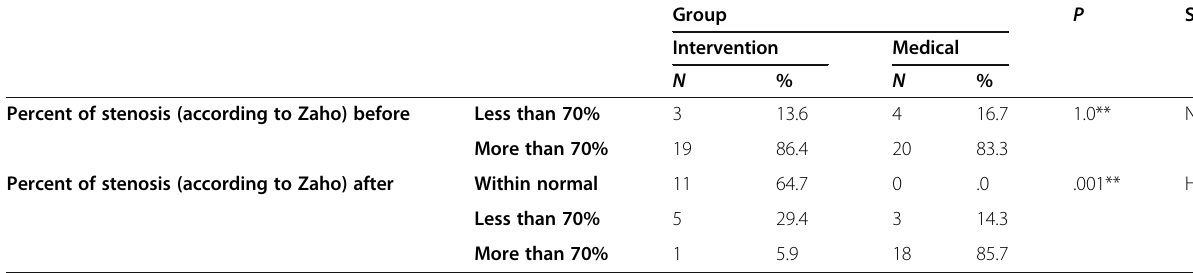
Table 8 Percent of stenosis among both groups